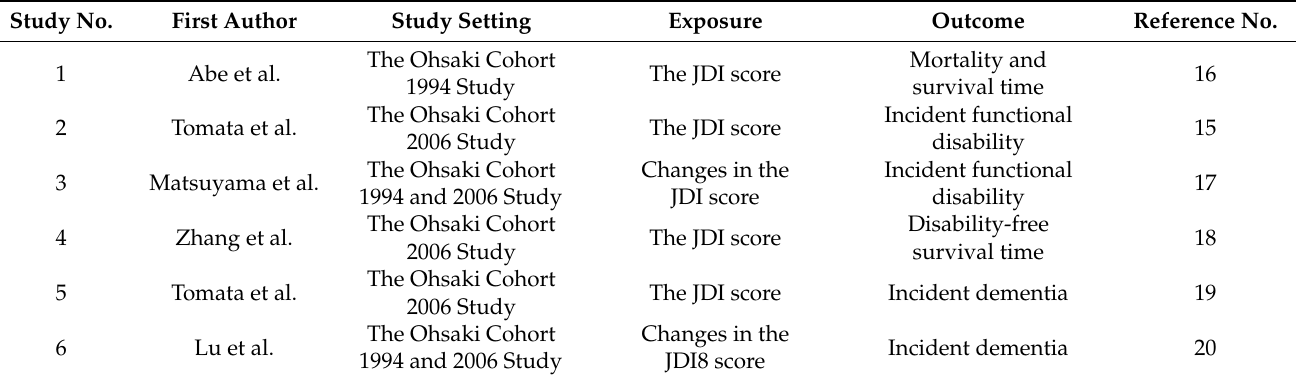
Table 1. Outline of published